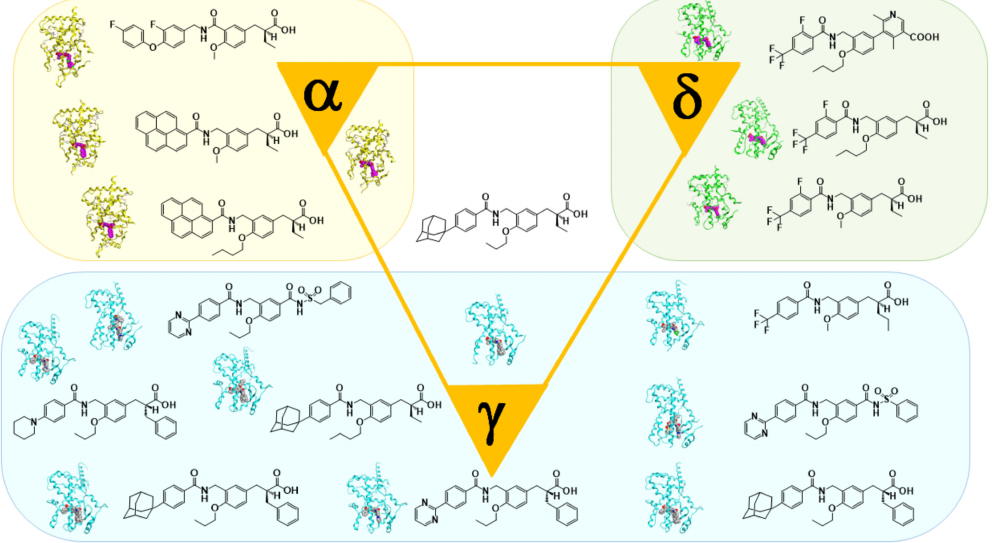
Figure 3. X-ray-crystallographic structures of our representative PPAR agonists complexed with each PPAR ligand binding domain